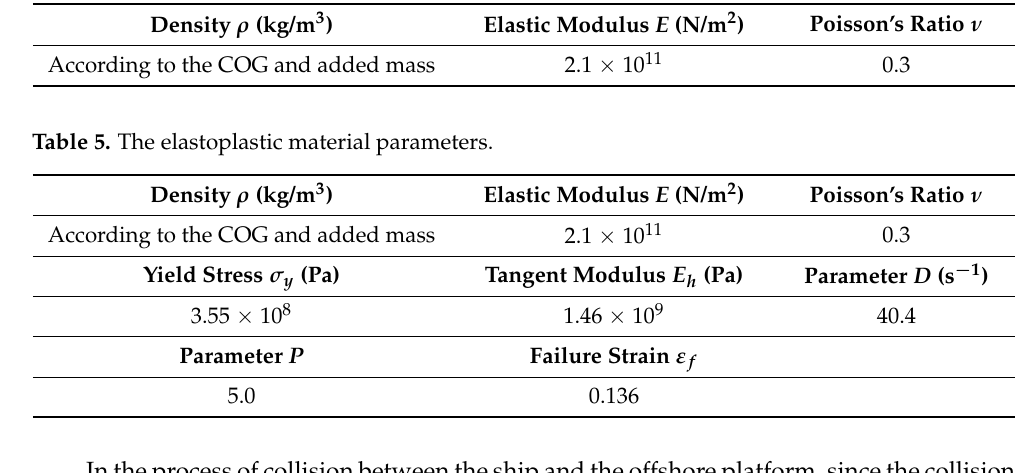
Table 7. The added mass coefficient under each collision condition .